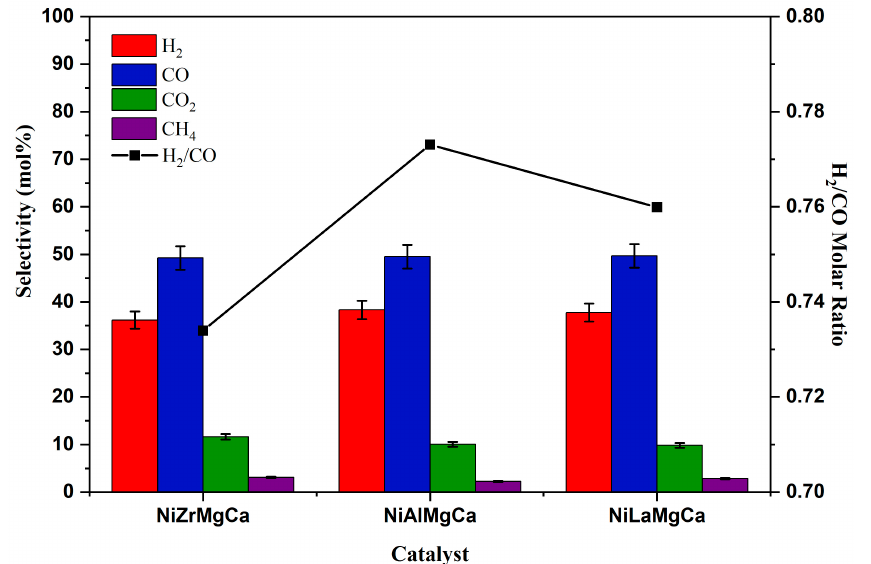
Figure 7. Selectivity of the gaseous products and the H 2 /CO molar ratio from the biomass module tar steam reforming over Ni-based catalyst (reaction condition: temperature = 800 °C; S/C ratio = 1; GHSV = 13,500 h − 1 ) .